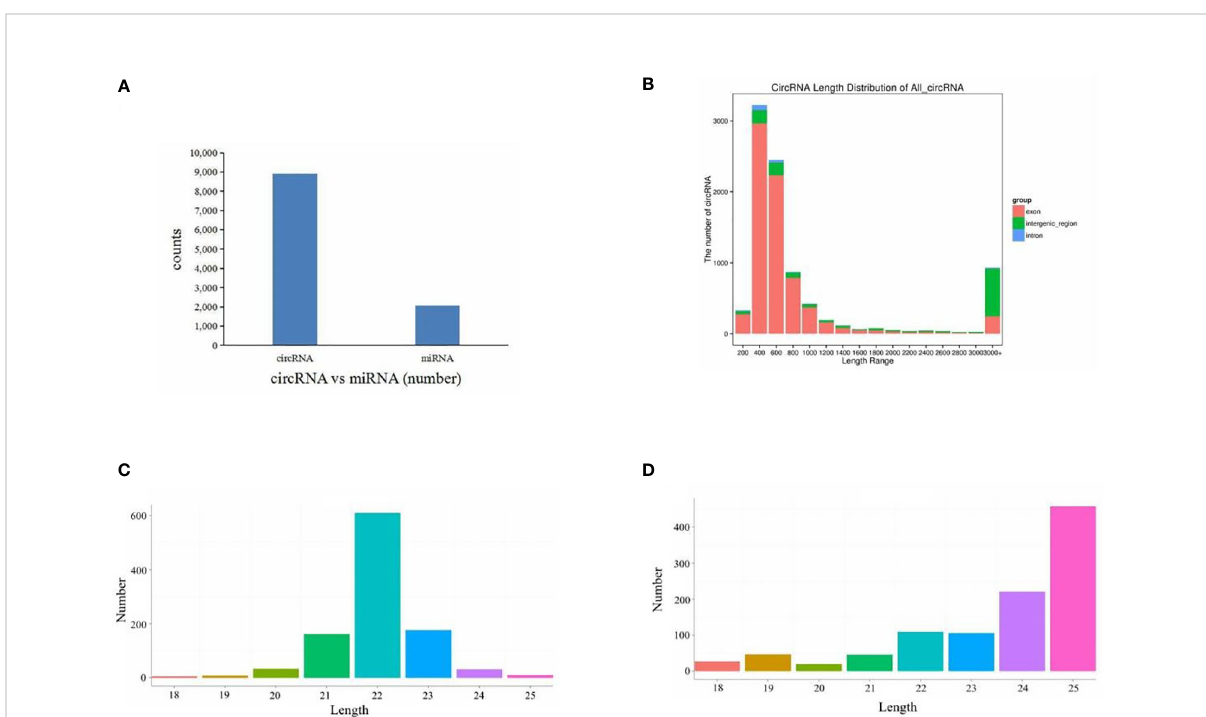
FIGURE 1 Overview of RNA sequencing. (A) Numbers of circRNAs and miRNAs. (B) All circRNA length distribution. (C) Known miRNA length distribution. (D) Novel miRNA length